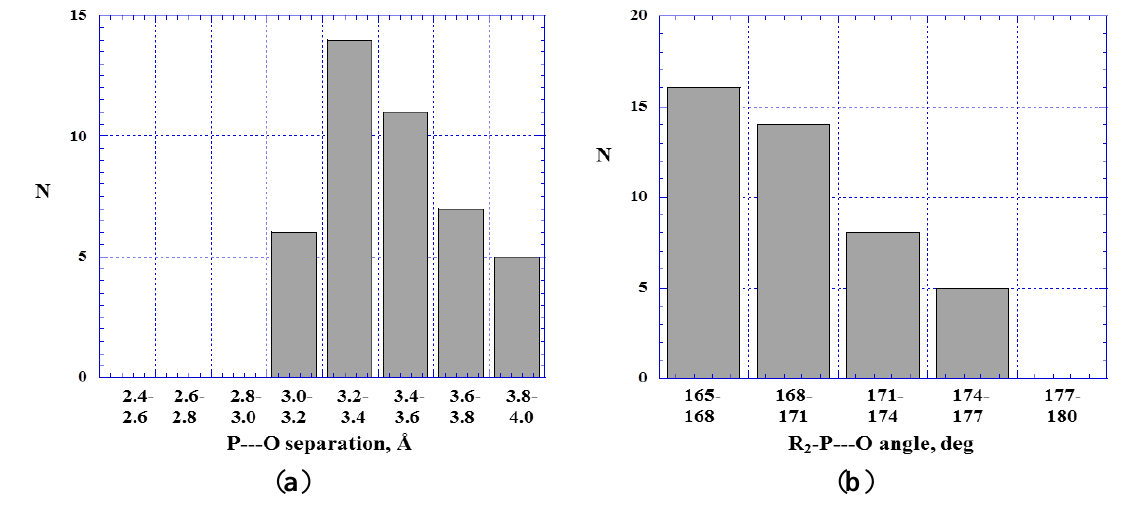
Figure 4. Histograms showing numbers N of R P---O separations ( a ) and R